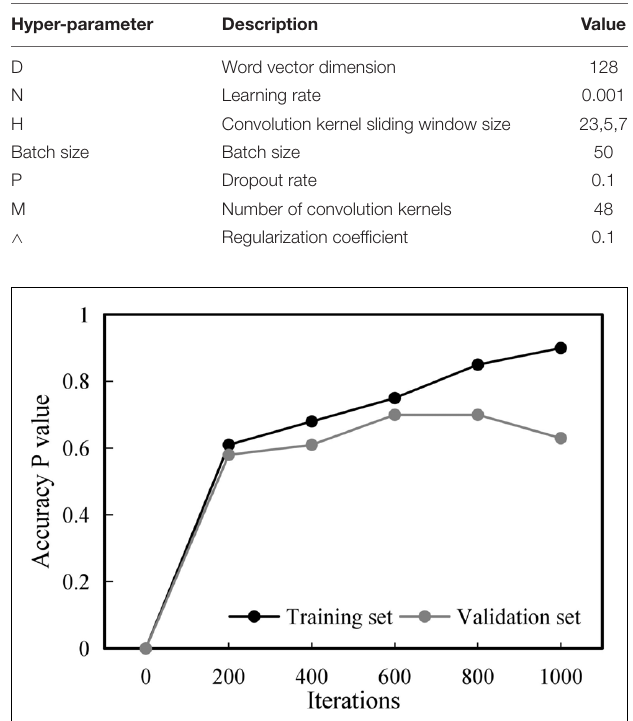
FIGURE 3 | Influence of iterations on the